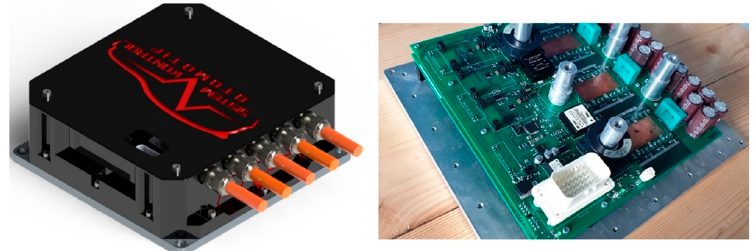
Figure 14. Snapshot of the developed